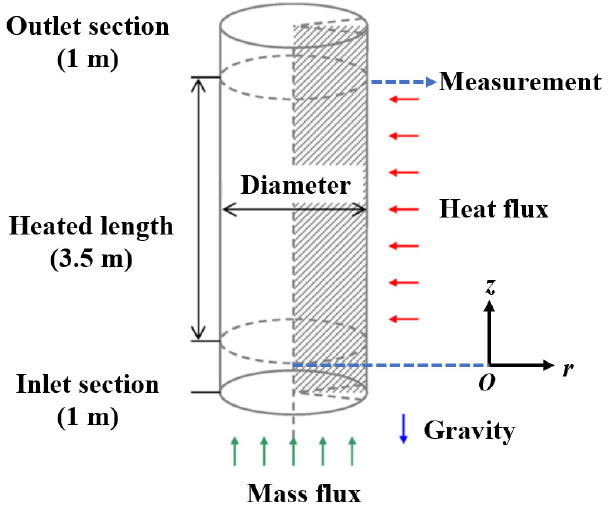
Figure 2. Illustration of DEBORA facility (measurement position is at z = 3.5 m).